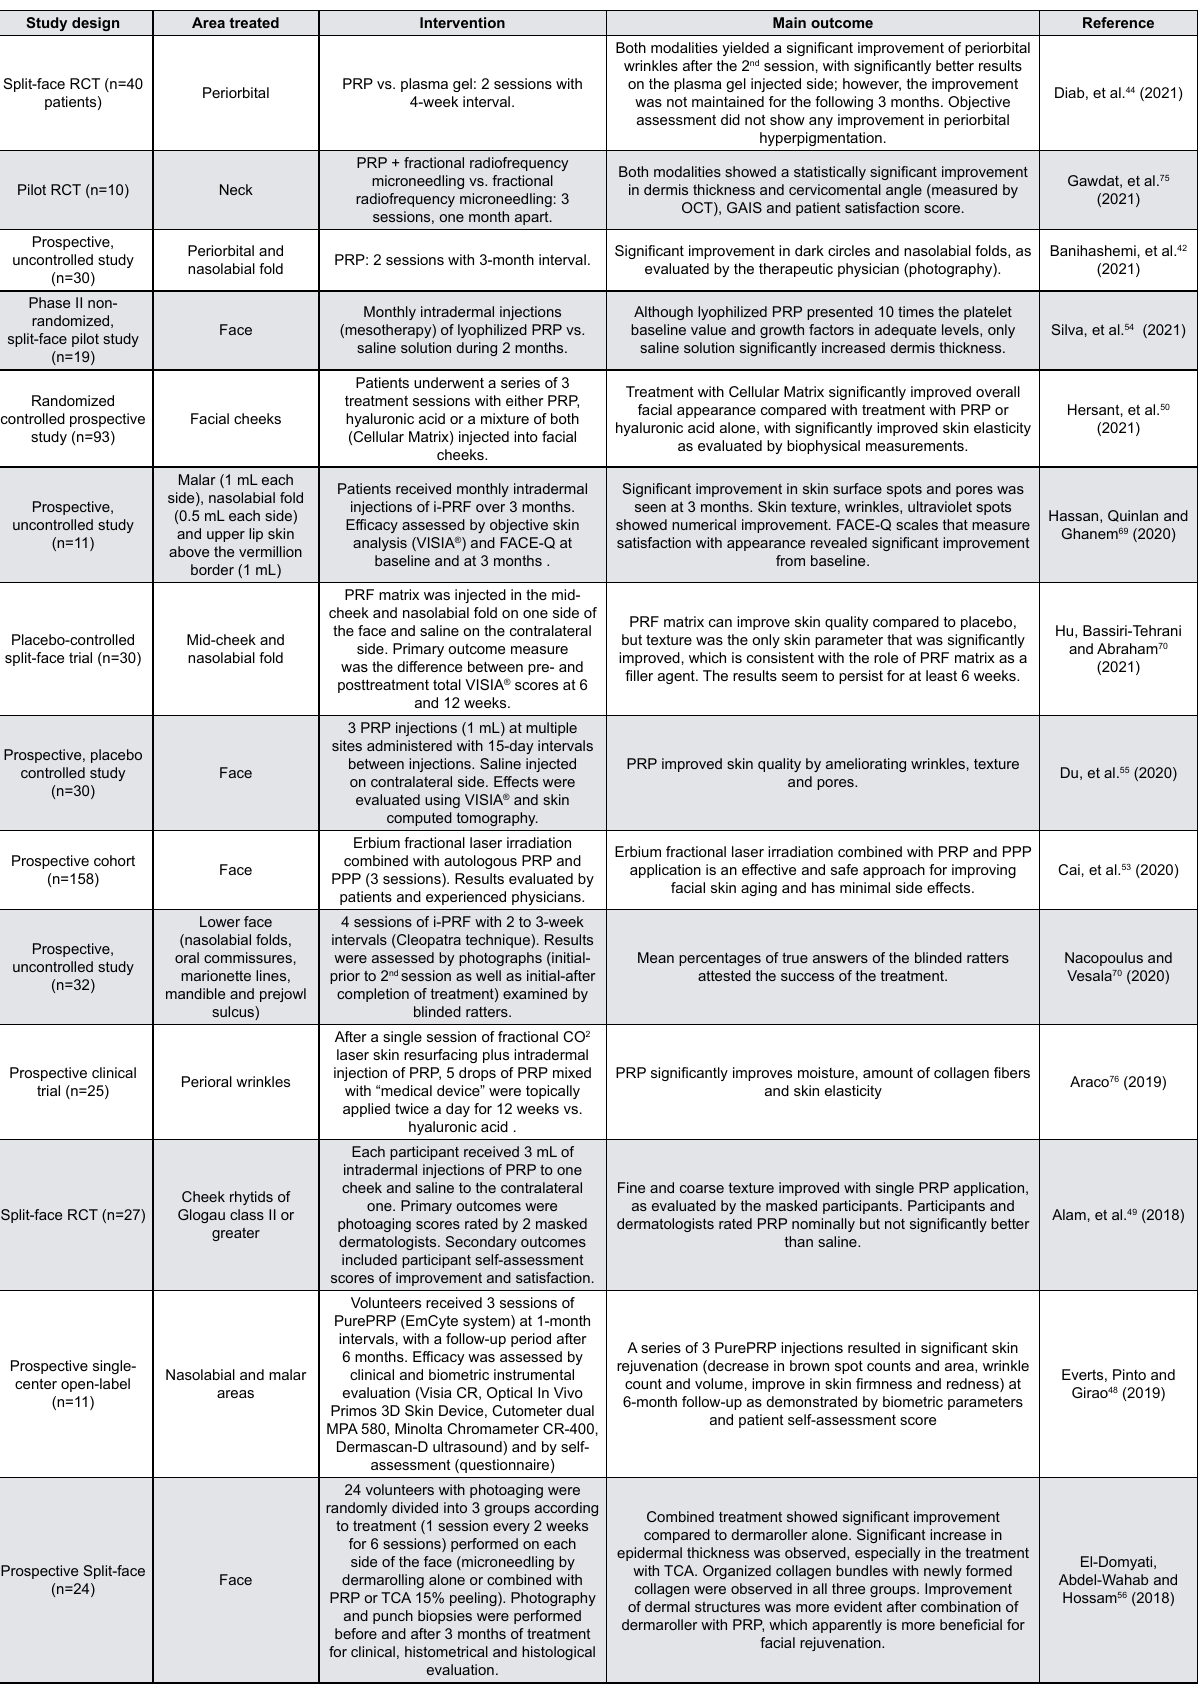
Figure 4- Clinical trials on the use of autologous platelet aggregates for facial